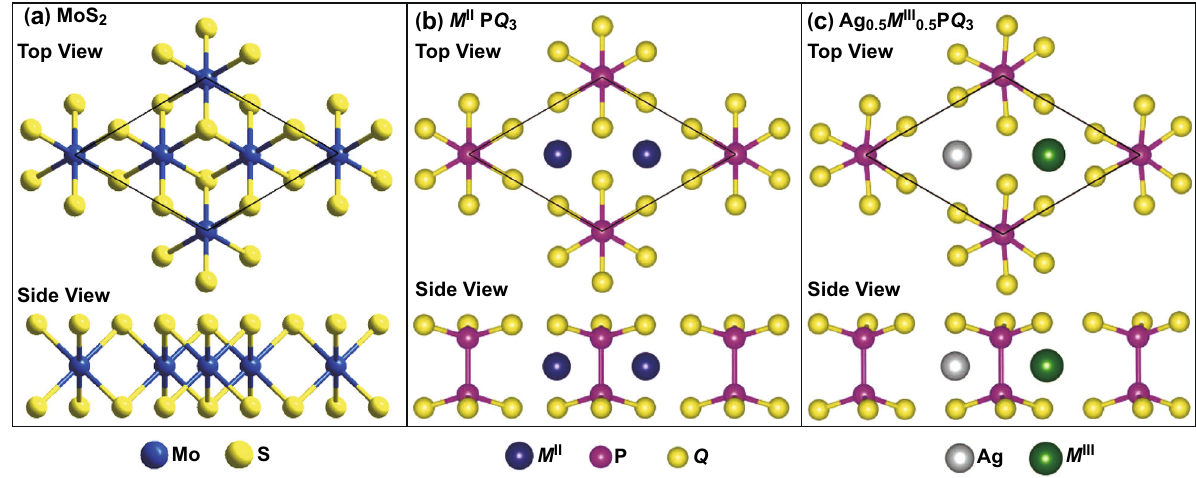
Fig. 1 Crystal structures of a MoS 2 , b M II PQ 3 (M II = Zn, Cd, Mg; X = S, Se), and c Ag 0.5 M 0.5III PQ 3 (M III = Sc, In; Q = S, Se). Bonds between metal atoms and Q atoms are not shown in b and c [49]. Reproduced with permission. Copyright (2014), AIP